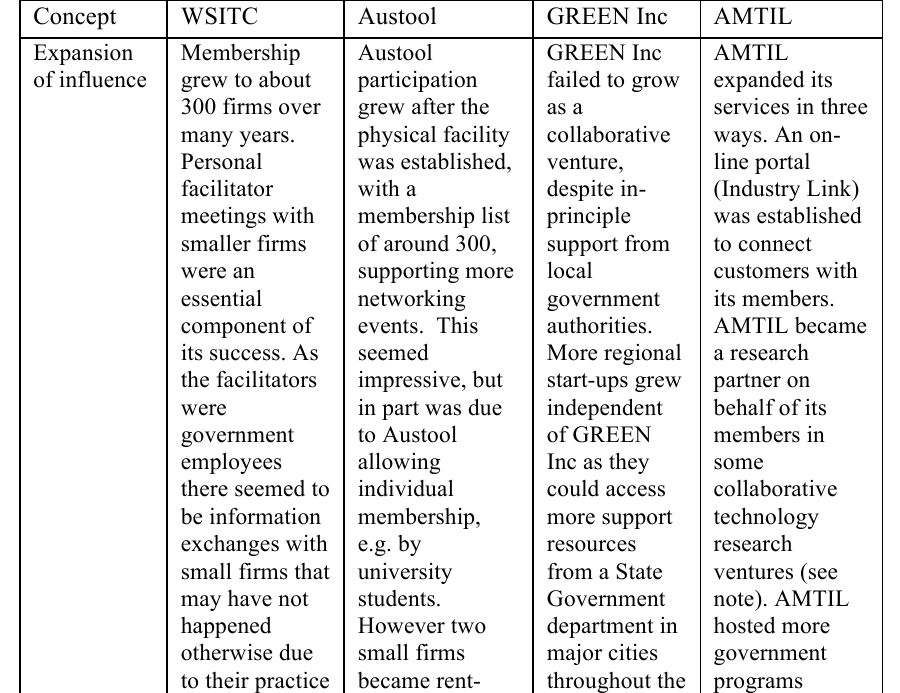
Table 7. Domination phase